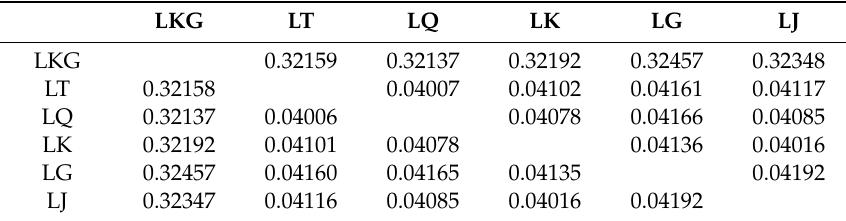
Table 5. The pairwise Fst values of di ff erent populations in G. dybowskii . LKG